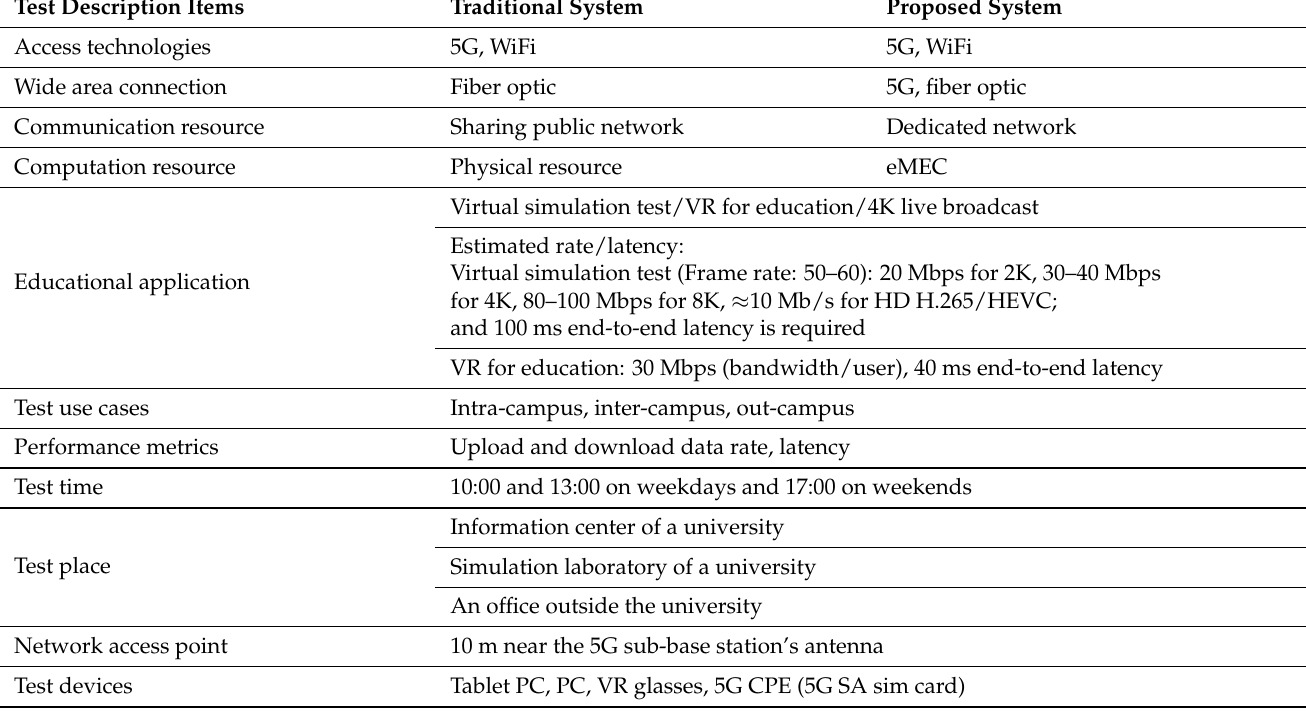
Table 1. Field test of system